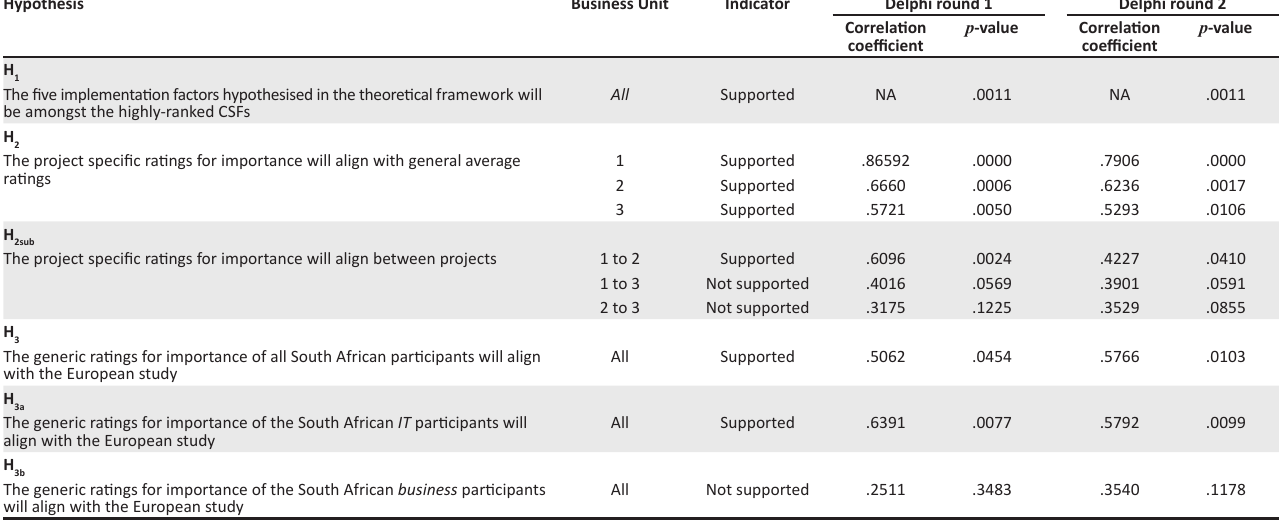
TABLE 4: Summary of hypothesis findings.